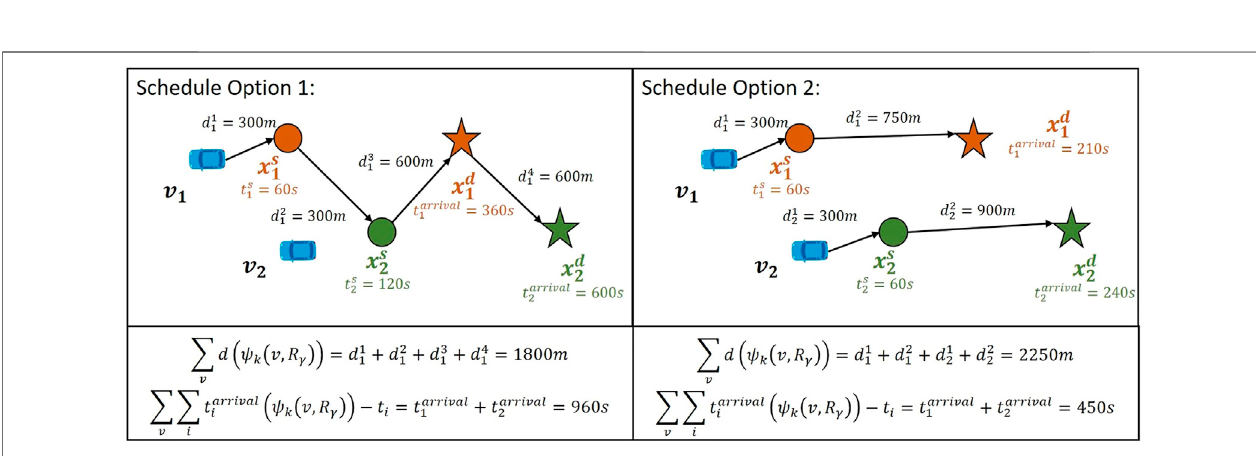
FIGURE 2 | Flowchart of the User Decision and Broker Decision scenarios. The only difference between the scenarios is the criteria used to choose an offer, highlighted in yellow.